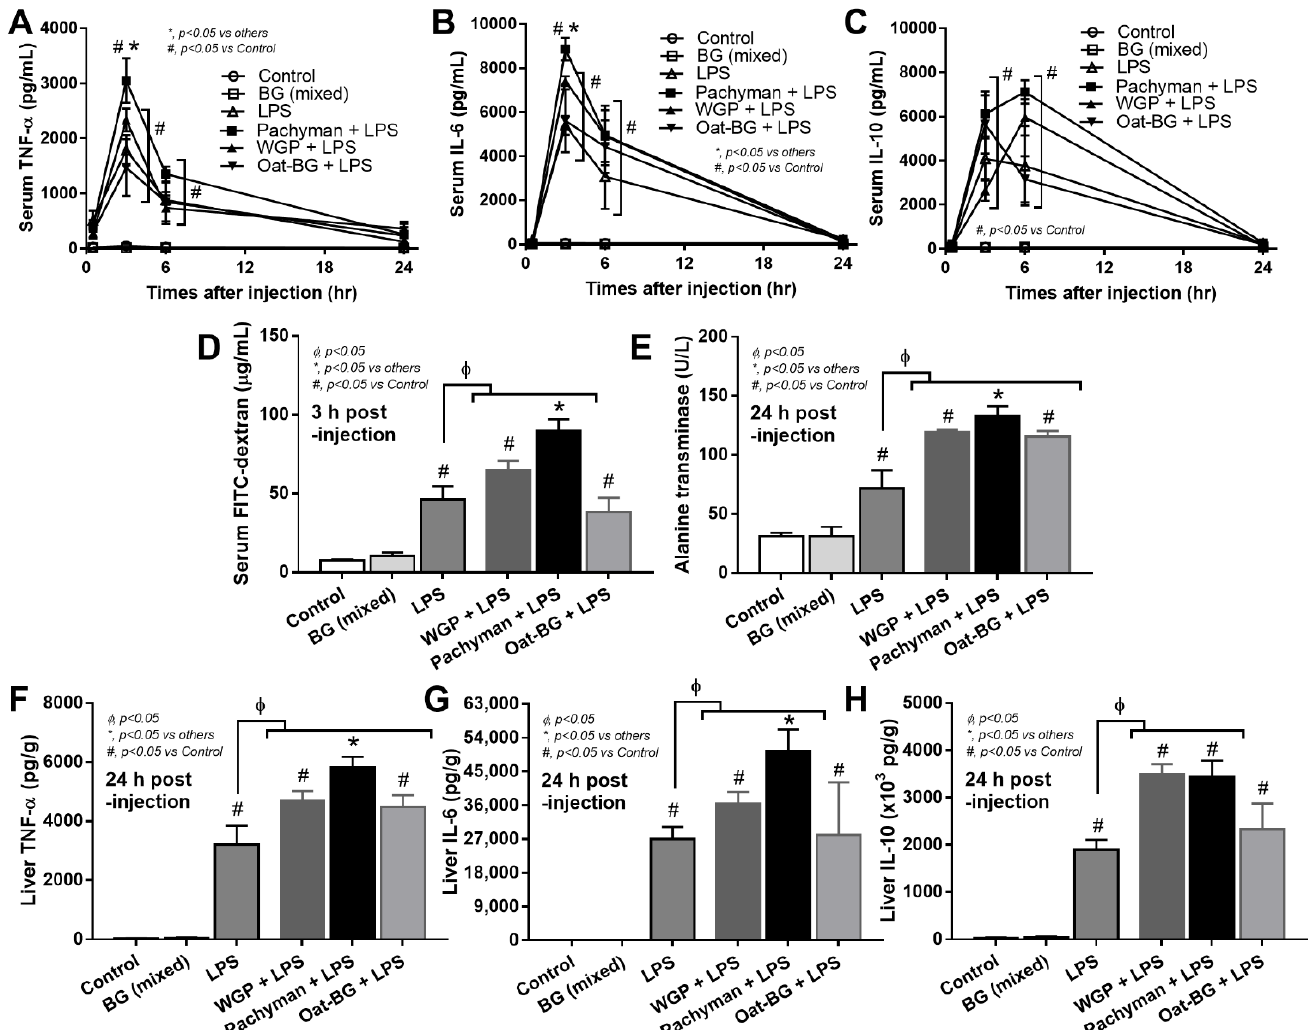
Figure 5. Characteristics of mice with drinking water (Control) with or without oral β -glucans gavage using whole-glucan particles (WGP), Pachyman, or Oat glucans (Oat-BG), which are combined into the BG (mixed) group or dextran sulfate solution with or without several glucans. The alteration in serum cytokines (TNF- α , IL-6, and IL-10); gut permeability (FITC-dextran assay); and liver enzyme (alanine transaminase) ( A – E ), together with liver cytokines (TNF- α , IL-6, and IL-10), ( F – H ) are shown ( n = 6–8/group). #, p < 0.05 vs. Control; *, p < 0.05 vs. other groups; φ , p < 0.05 vs. the indicated group as determined by ANOVA with Tukey’s analysis. Data from oral glucan-administered mice using different types of glucans were combined as the BG (mixed) due to the nonsignificant different values among the groups with glucan injection alone.